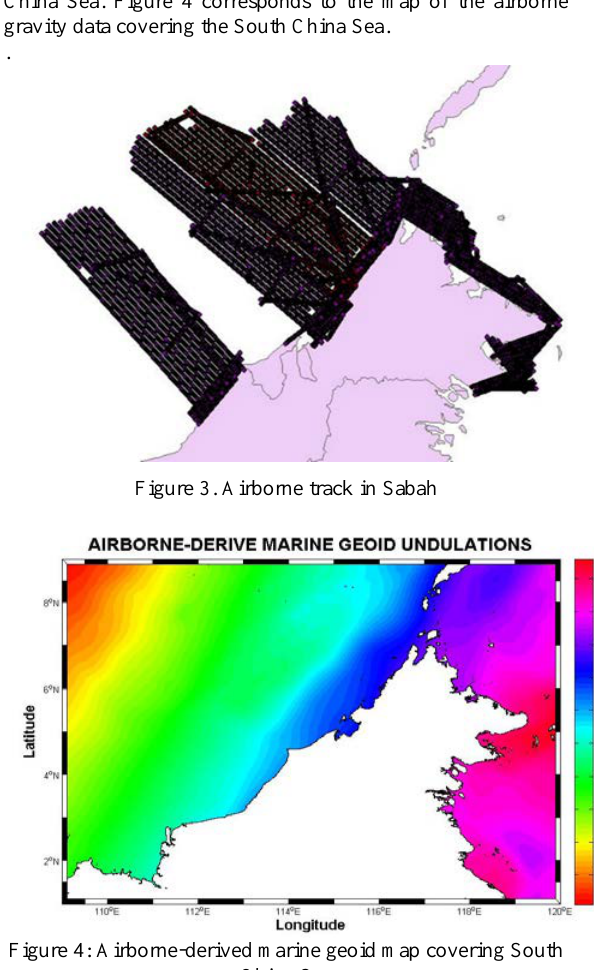
Figure 4: Airborne-derived marine geoid map covering South China